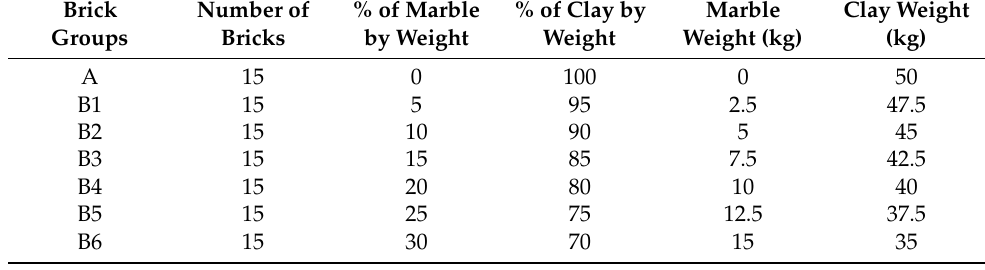
Figure 1. View of: ( a ) clay sample, and ( b ) mixing of clay and marble dust.